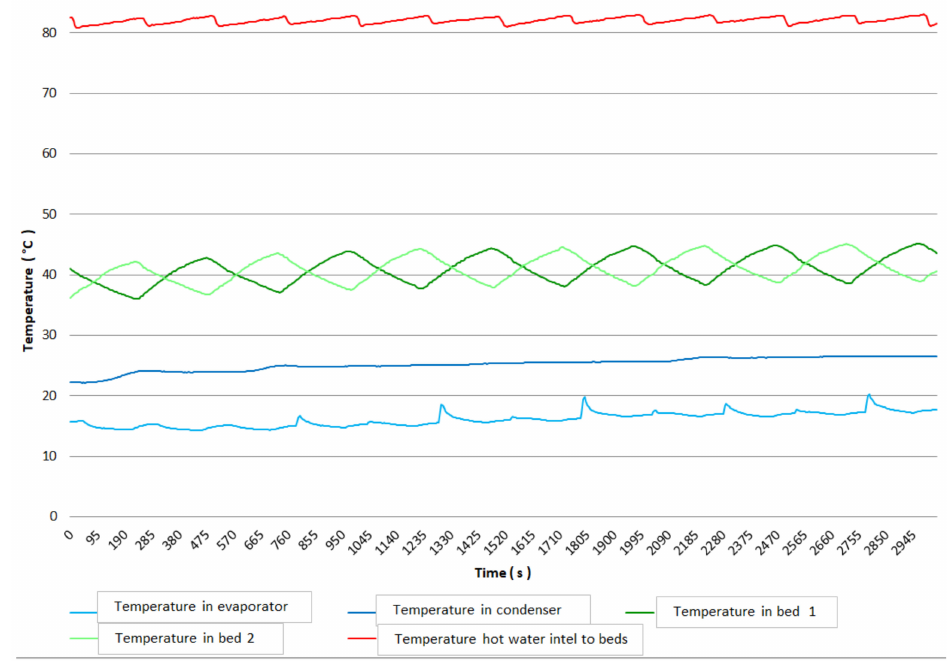
Figure 5. Changes in temperature in the adsorption chiller components during the testing.